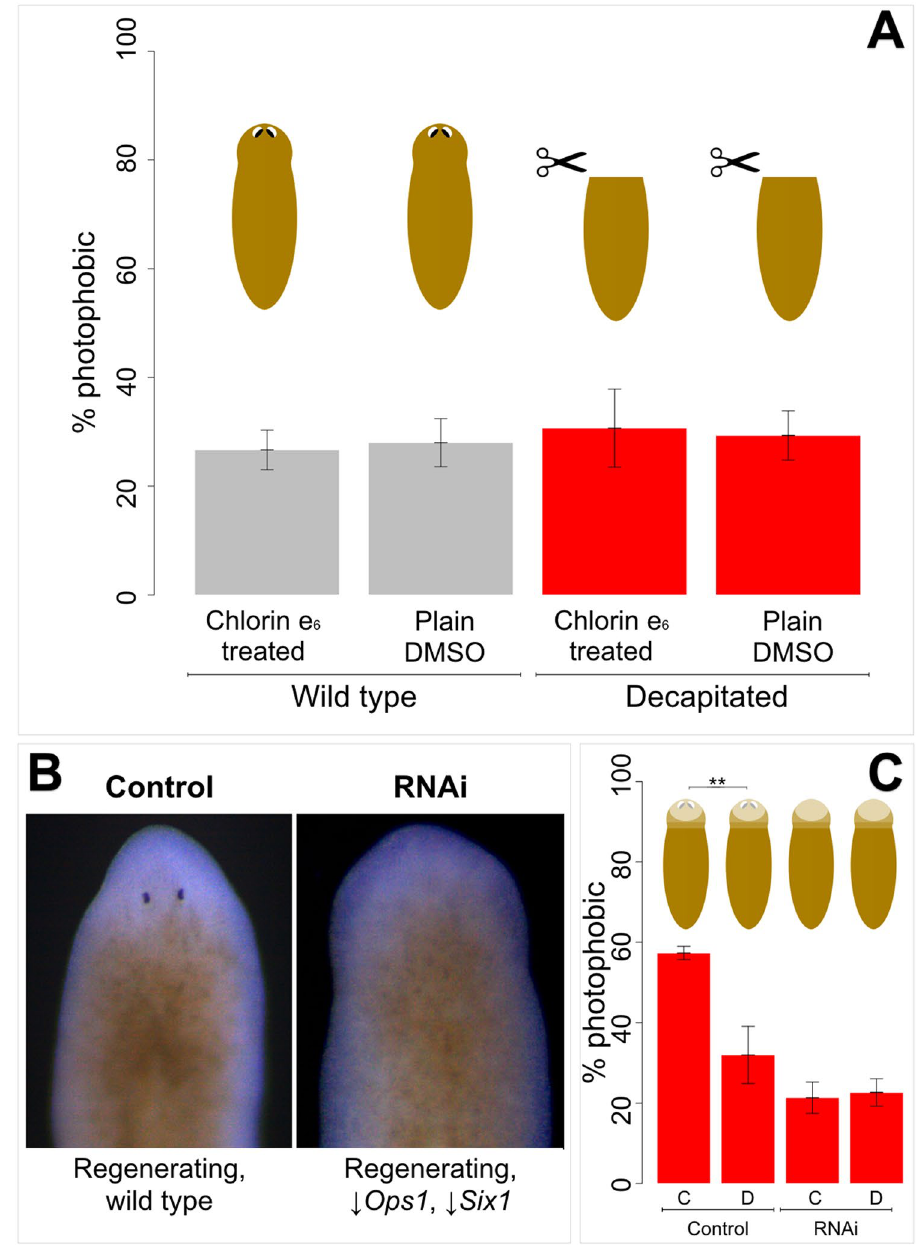
Figure 2. Vision is required for chlorin e 6 -triggered red-light avoidance. ( A ) bar charts reporting the percentage of photophobic animals, either treated with chlorin e 6 or plain dimethyl sulfoxide, in absence of light stimulus (Wild type, grey bars) or after exposure to red light at 5 mW of radiant power (Decapitated, red bars). n = 5, 15 specimens per experiment, 75 animals per class; error bars report standard error of the mean. ( B ) Representative pictures of regenerating animals following RNA interference (RNAi, reported as ↓ Ops1 , s Six1 ) or simple incubation on ice (Control). RNAi individuals had eyeless phenotype, and a 99% opsin reduction (assessed via qPCR). ( C ) Bar charts reporting the percentage of photophobic animals (RNAi or Control), either treated with chlorin e6 ( C ) or plain dimethyl sulfoxide ( D ), after exposure to red light at 5 mW of radiant power. Two asterisks indicate significance for unpaired one-tailed T-test (for p < 0.01); the difference shown is also significant for two-tailed Mann Whitney U-test (for p < 0.05). n = 5, 15 specimens per experiment, 75 animals per class; error bars report standard error of the